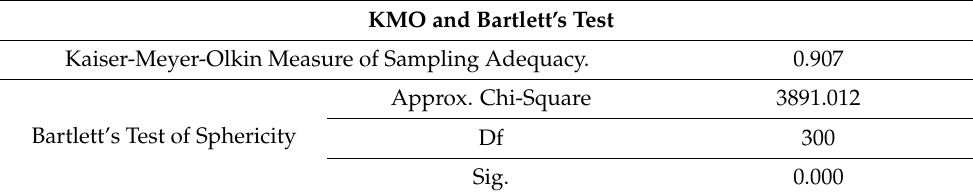
Table 3. KMO and Bartlett’s test of stakeholders’ participation.